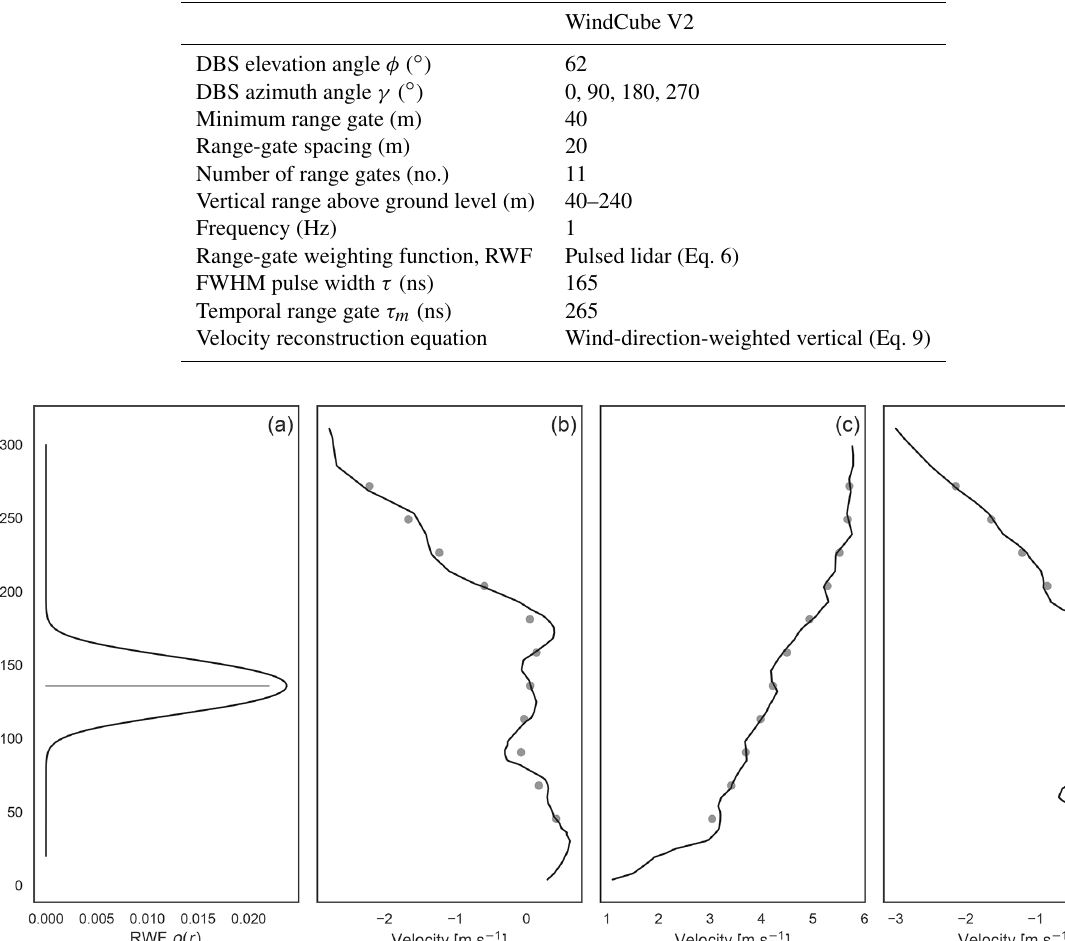
Table 1. Parameters used in the model to configure a representative WindCube V2 lidar performing a DBS scan.